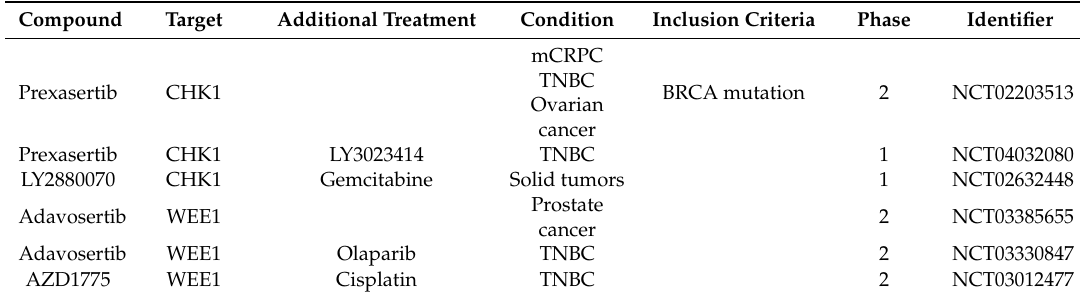
Table 3. Selected clinical trials evaluating CHK1 or WEE1 inhibitors in solid tumors including prostate or breast